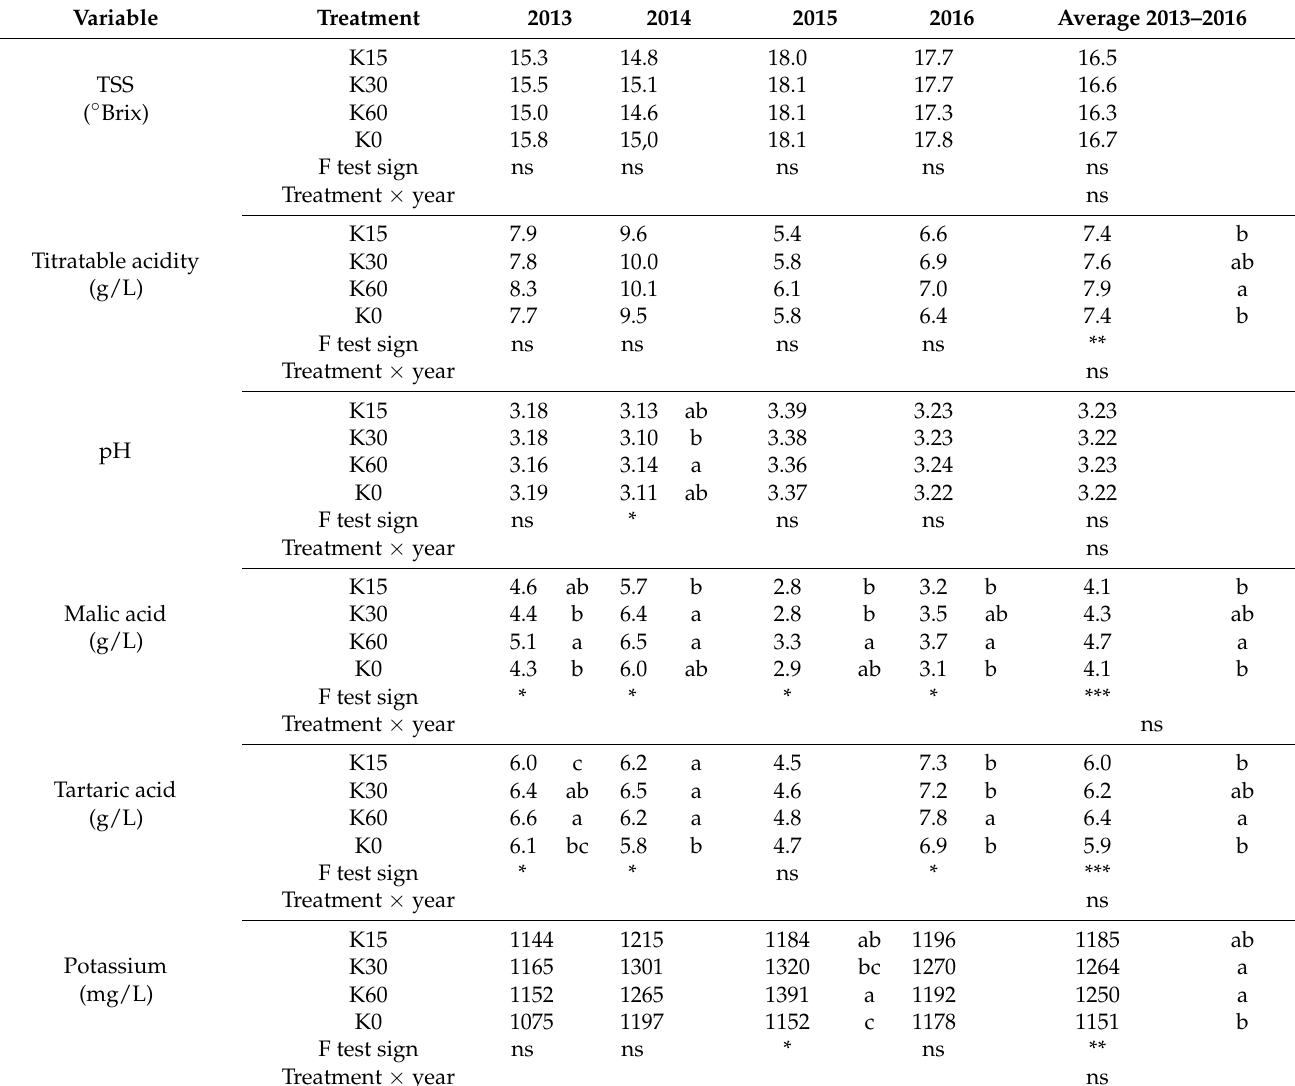
Table 4. Fruit composition of Glera vines in response to different K supply treatments. Means followed by different letters